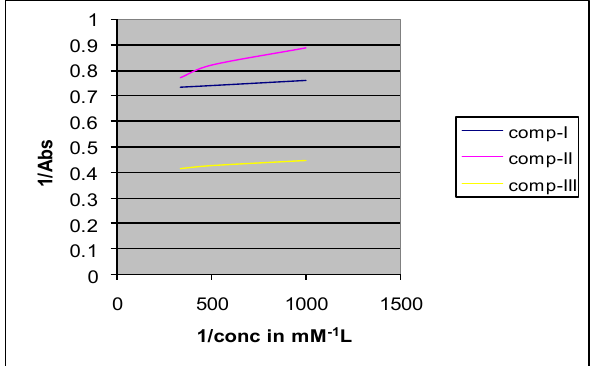
Figure 2: Plot of 1/ O.D. vs. Conc. of Compound I, II and III.